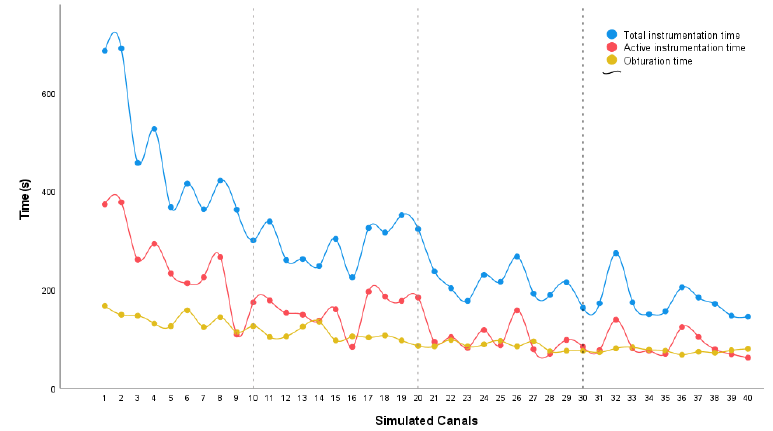
Figure 3. Pro fi le graph of total instrumentation, active instrumentation, and obturation times per group (10 canals) by preparation order.